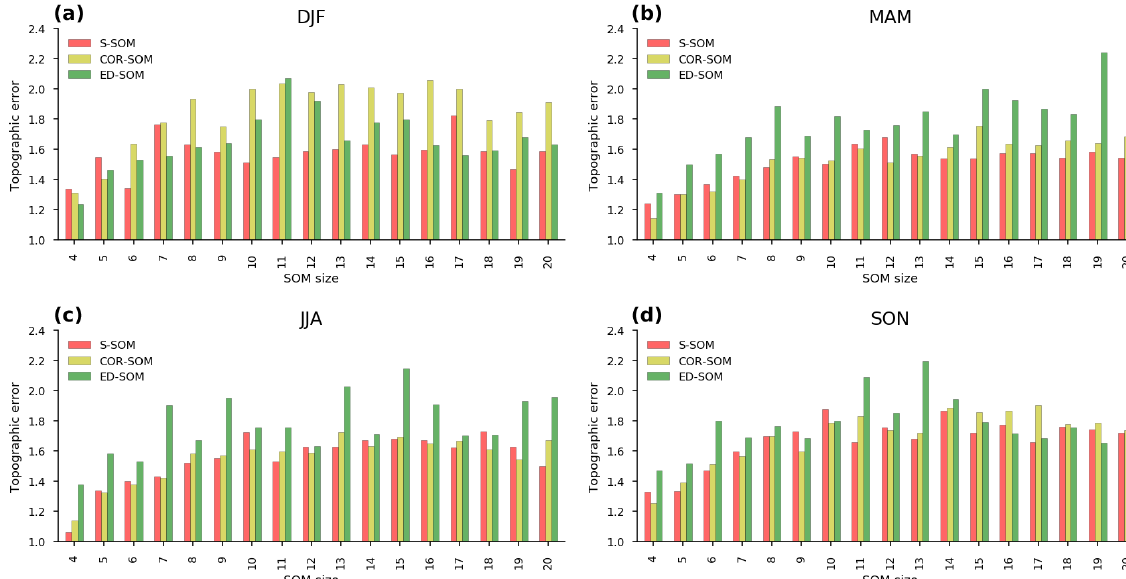
Figure 7. Comparison of topographic errors of S-, COR-, and ED-SOM for all SOM size configurations and four seasons, i.e., DJF, MAM, JJA, SON. In each plot, the x axis indicates a different SOM simulation (size configuration), and the y axis indicates topographic